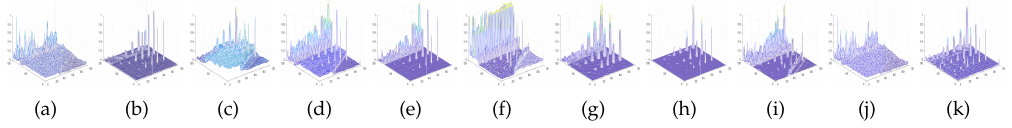
Figure 10. Three-dimensional plots of detection results for the synthetic dataset. ( a ) GRX; ( b ) BJSRD;